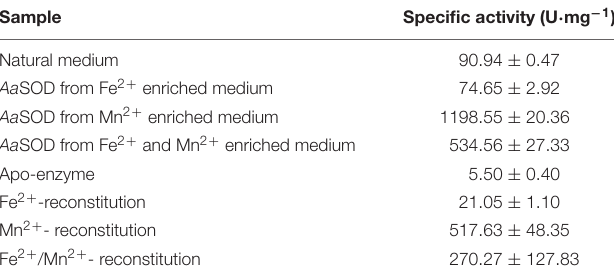
TABLE 1 | Superoxide dismutase (SOD) activity incorporating various ions.